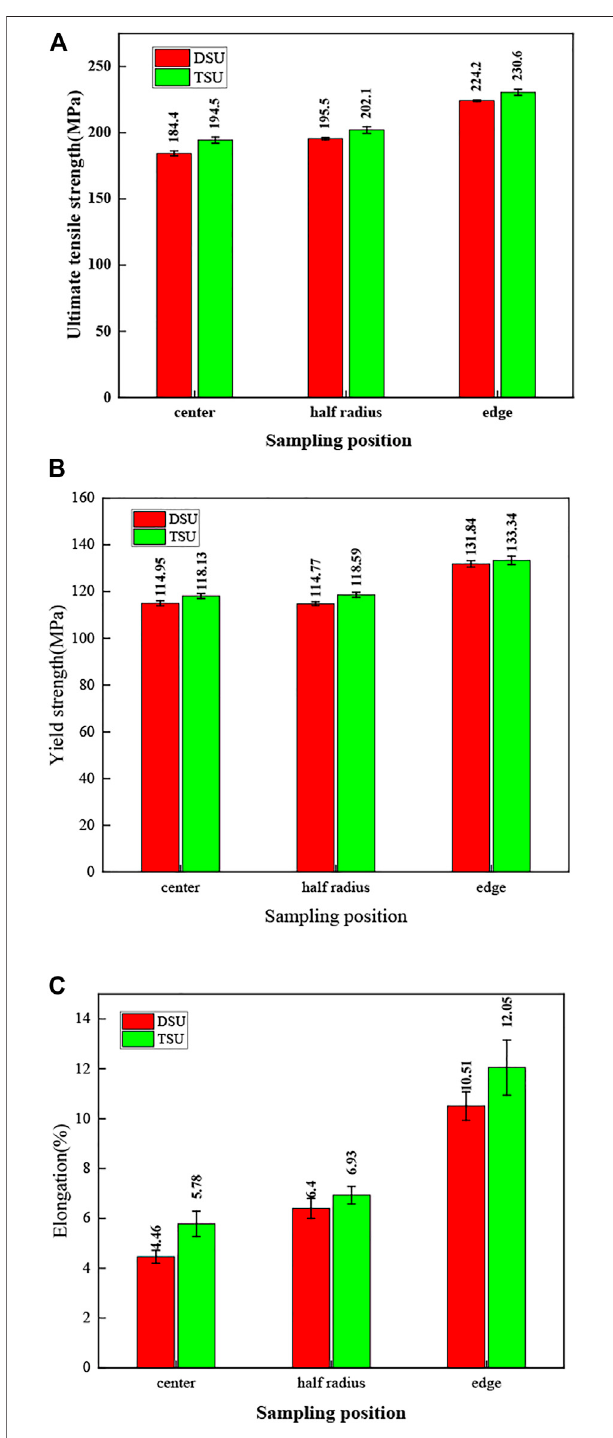
FIGURE 10 | Mechanical properties: (A) TS, (B) YS, and (C) EL determined at different positions.